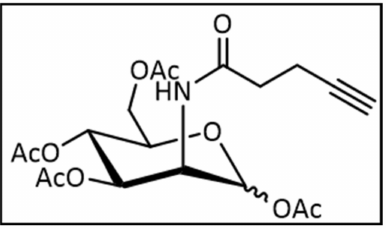
Figure 6. Structural formula of 2-( N -4-Pentynoyl)-2-Deoxy-(1,3,4,6)-Tetra- O -Acetyl- D -